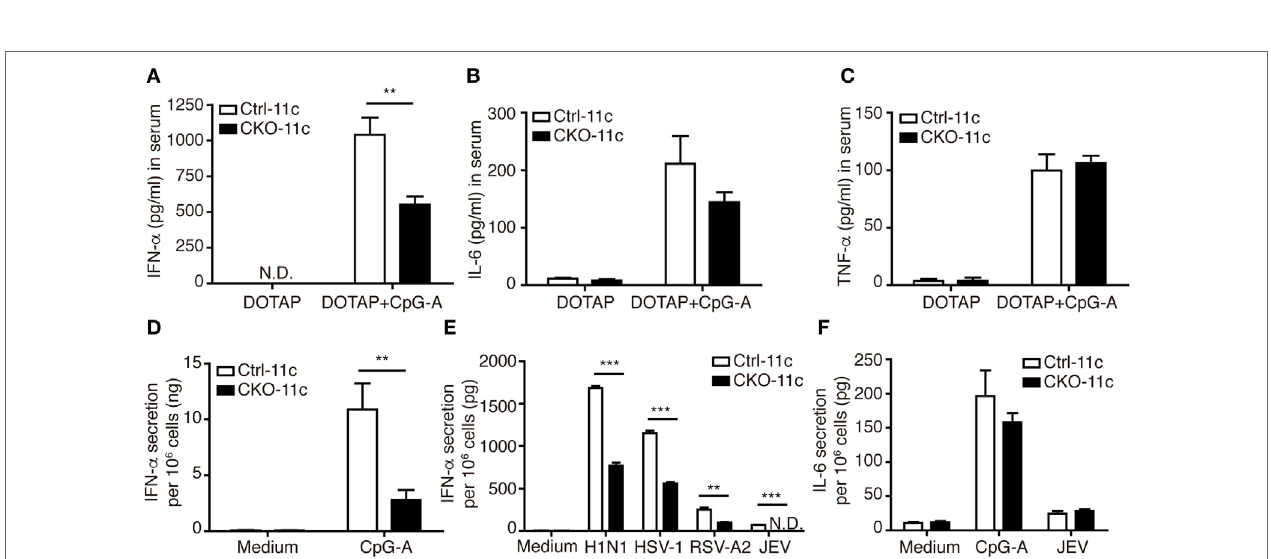
FigUre 3 | Type I IFN (IFN-I) production was impaired in CKO-11c mice and in plasmacytoid dendritic cells (pDCs) from CKO-11c mice. (a) ELISA showing the levels of IFN- α production in the serum of Ctrl-11c and CKO-11c mice 6 h after intravenous injection with 5 µg CpG-A + DOTAP or DOTAP alone. (B,c) ELISA determining the levels of IL-6 (B) and TNF- α (c) in serum from Ctrl-11c and CKO-11c mice from panel (a) . (D,e) ELISA determining the levels of IFN- α production at 24 h in medium alone treated, 1 µM CpG-A-stimulated or virus-infected splenic pDCs isolated from Ctrl-11c and CKO-11c mice. (F) ELISA measurement of the levels of IL-6 produced by Ctrl-11c and CKO-11c splenic pDCs at 24 h after treatment with medium alone, 1 µM CpG-A and Japanese encephalitis virus (JEV) at MOI of 10. Data represent the mean ± SEM and were analyzed by two-tailed unpaired Student’s t -test [ n = 3 in DOTAP, 5 − 7 in CpG-A + DOTAP in (a) , 3 − 4 in (B,c) , 3 in medium, 6 in CpG-A treated group in (D) , 3 in (e) , and 3 − 4 in (F) ]. ** p < 0.01; *** p < 0.001. N.D. = not detectable.